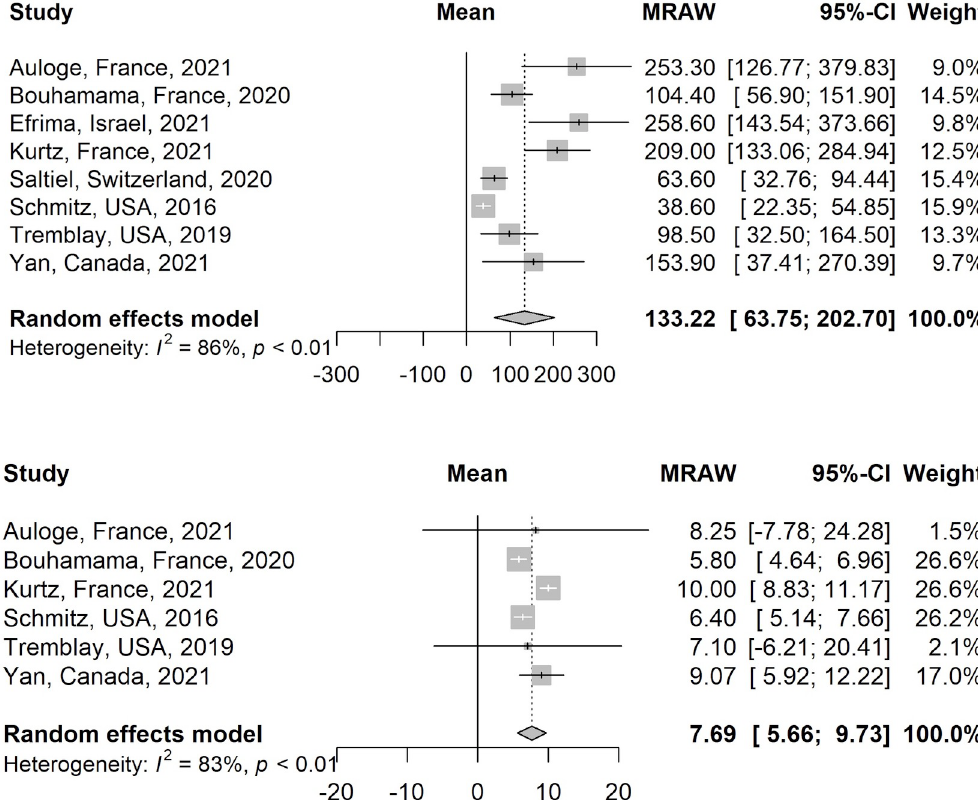
Fig 2. Comparison of the pre-ablation tumor volume (Fig 2A) and diameter (Fig 2B) across the selected